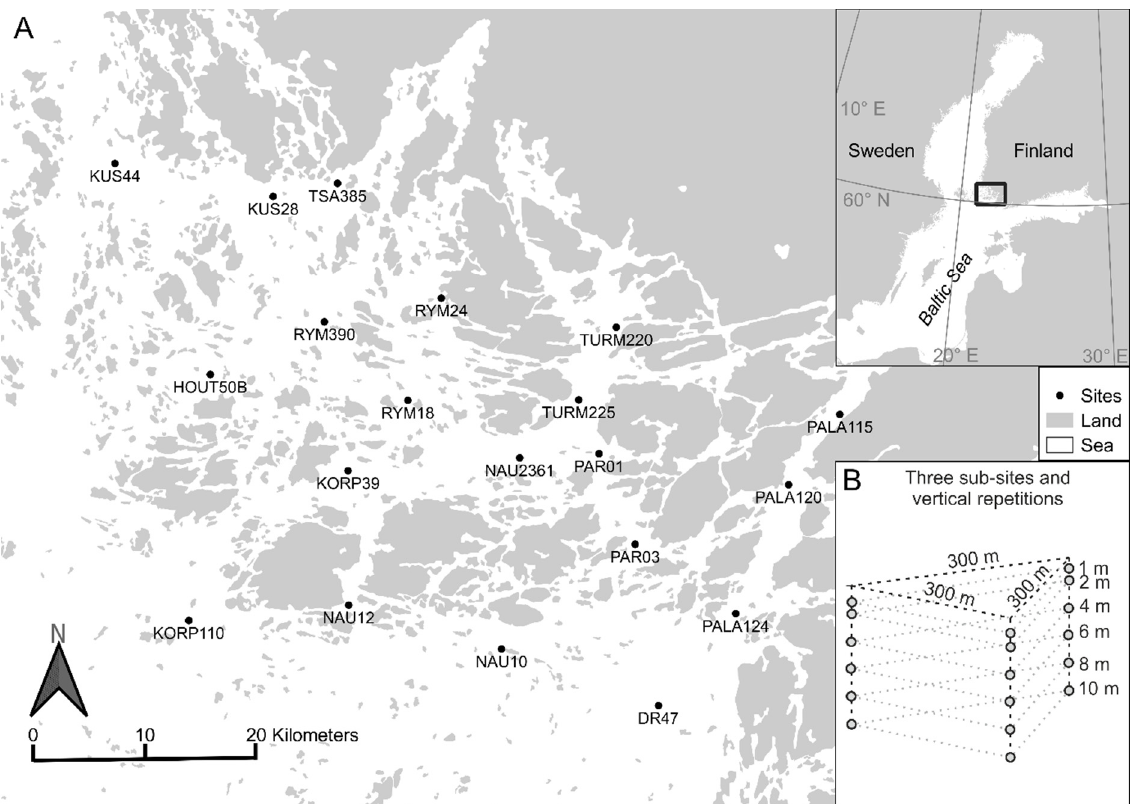
Figure 2. ( A ) The 20 sampling sites in the SW Finnish archipelago in 2007. ( B ) Sub-site sampling pattern with three parallel depth profiles at one sampling site (redrawn and modified from